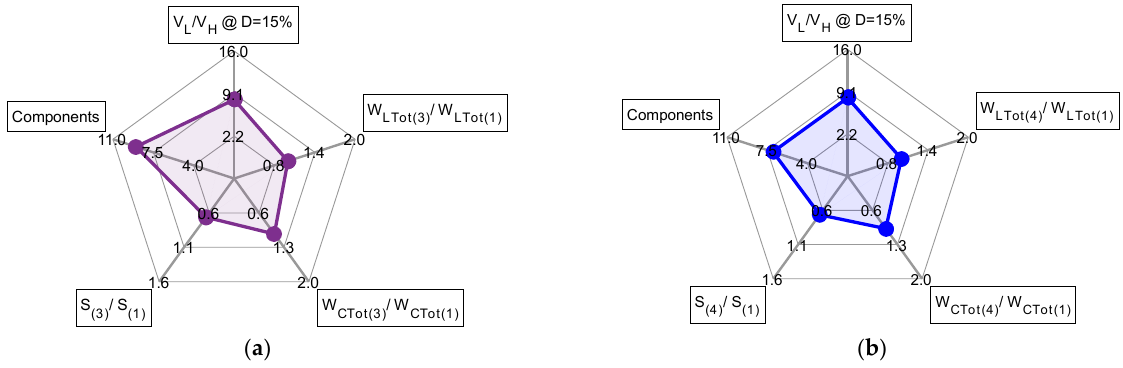
Figure 11. Radar chart with 5 axes: voltage conversion ratio (@D = 15%); number of components; total active switch stress; mean inductor energy; mean capacitor energy. ( a ) Chart of converter 3. ( b ) Chart of converter 4.